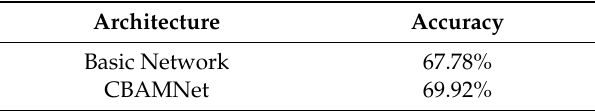
Table 2. Comparison of Basic